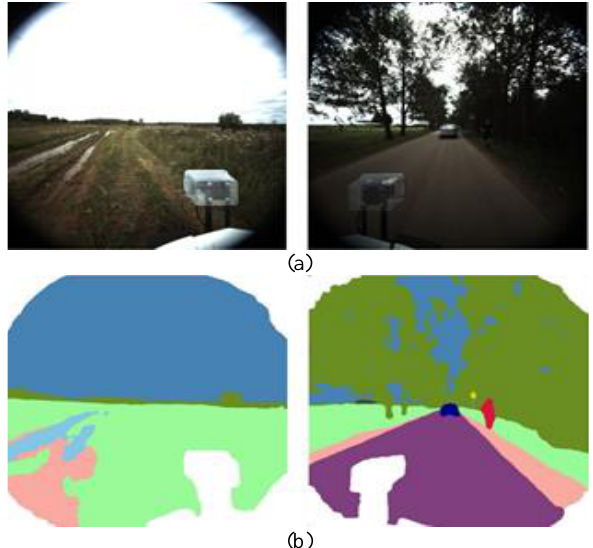
Figure 11. Original images (a) from our off-road dataset and results of the proposed algorithm (b)